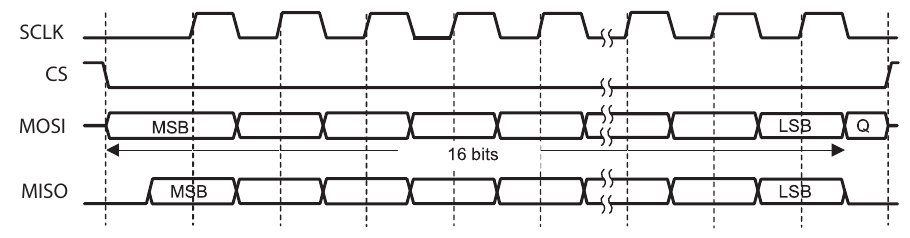
Figure 6. SPI transaction timing diagram and signals Serial Clock (SCKL), Chip Select (CS), Master Out Slave In (MOSI), and Master In Slave Out (MISO).